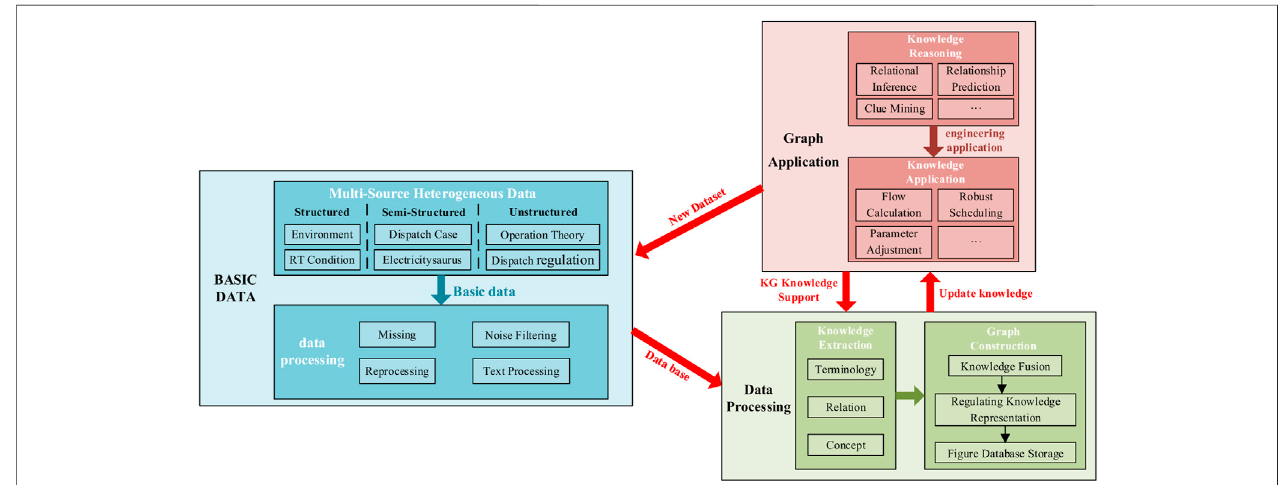
FIGURE 2 | Power system dispatching operation knowledge graph